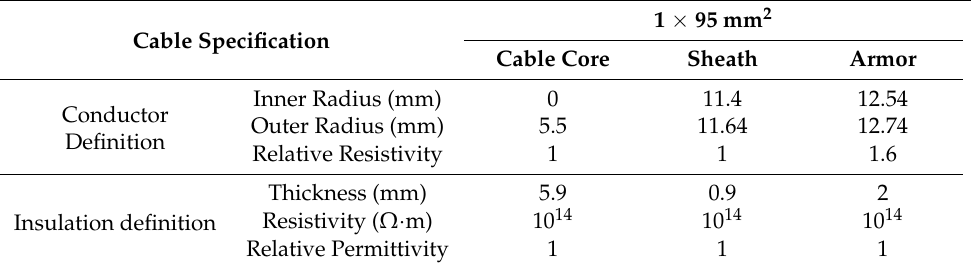
Table 3. Single-core cable model